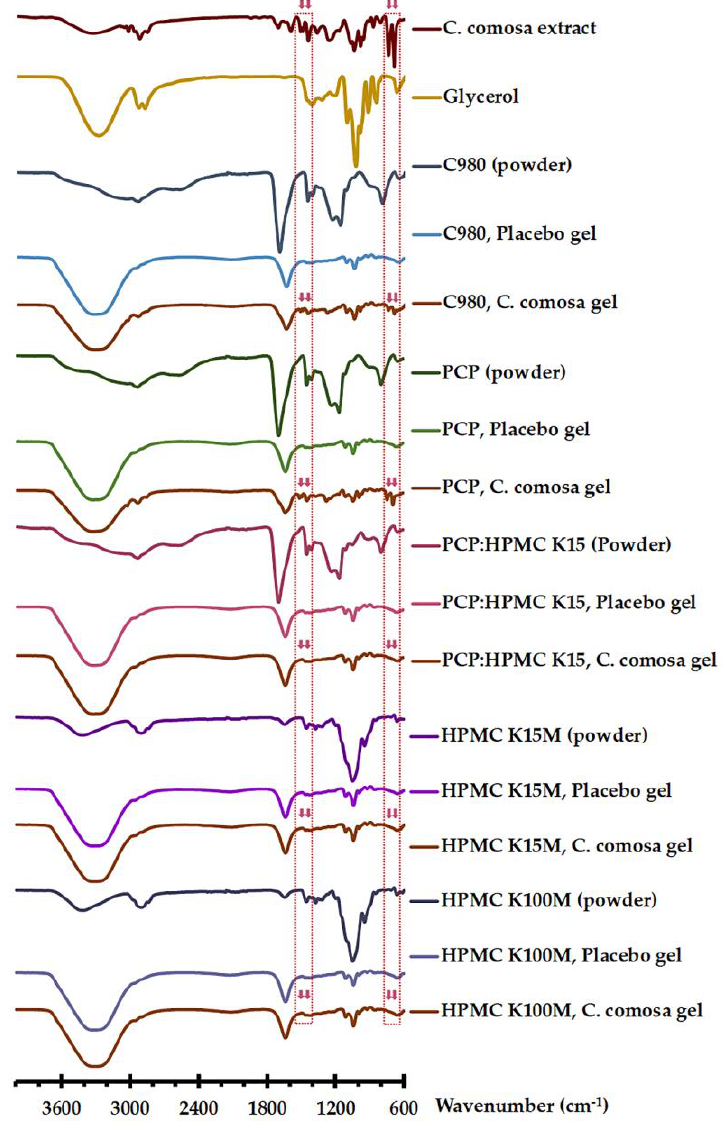
Figure 3. ATR-FTIR of C. comosa extract, glycerol, mucoadhesive polymers, placebo gels, and C. comosa gels.